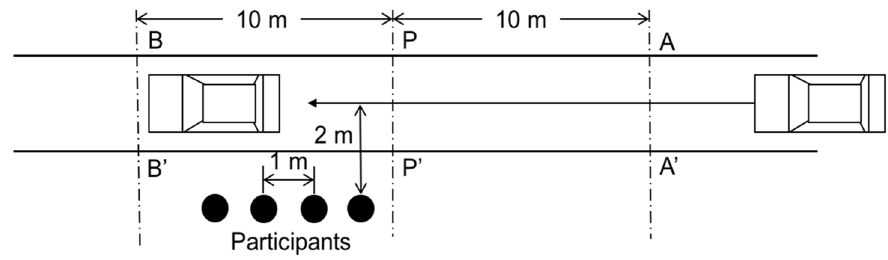
Figure 1. Positions of the participants and the quiet vehicle.